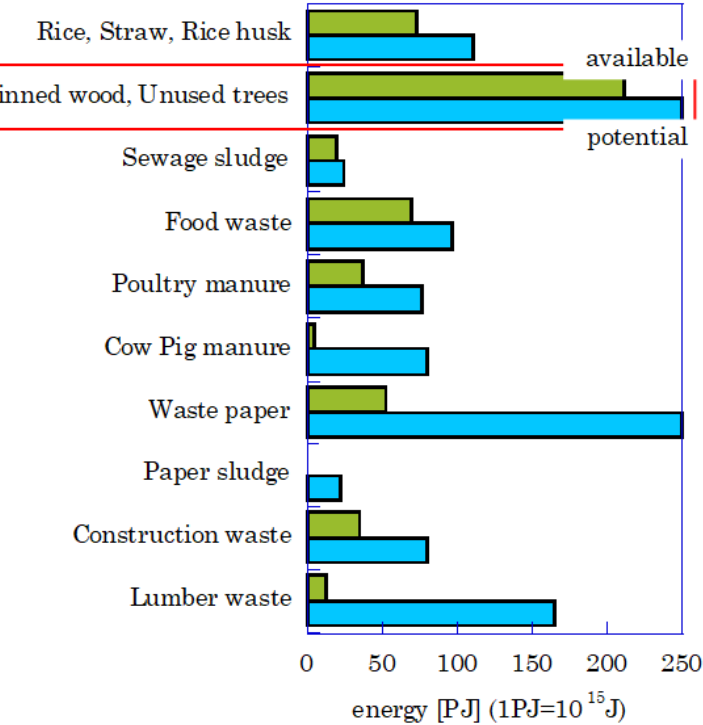
Figure 1. Biomass energy resources in Japan. The potential and availability of wood (red box) are large.